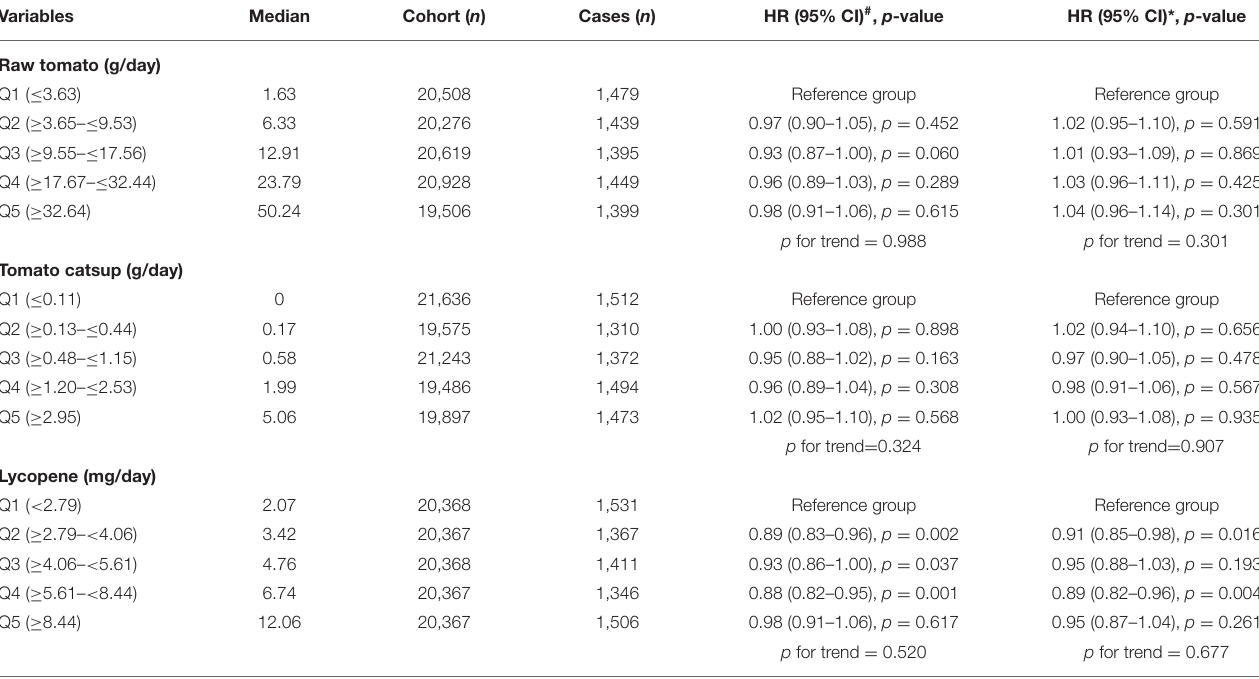
TABLE 4 | Associations between intake of raw tomato, tomato catsup or lycopene, and cancer mortality. Variables